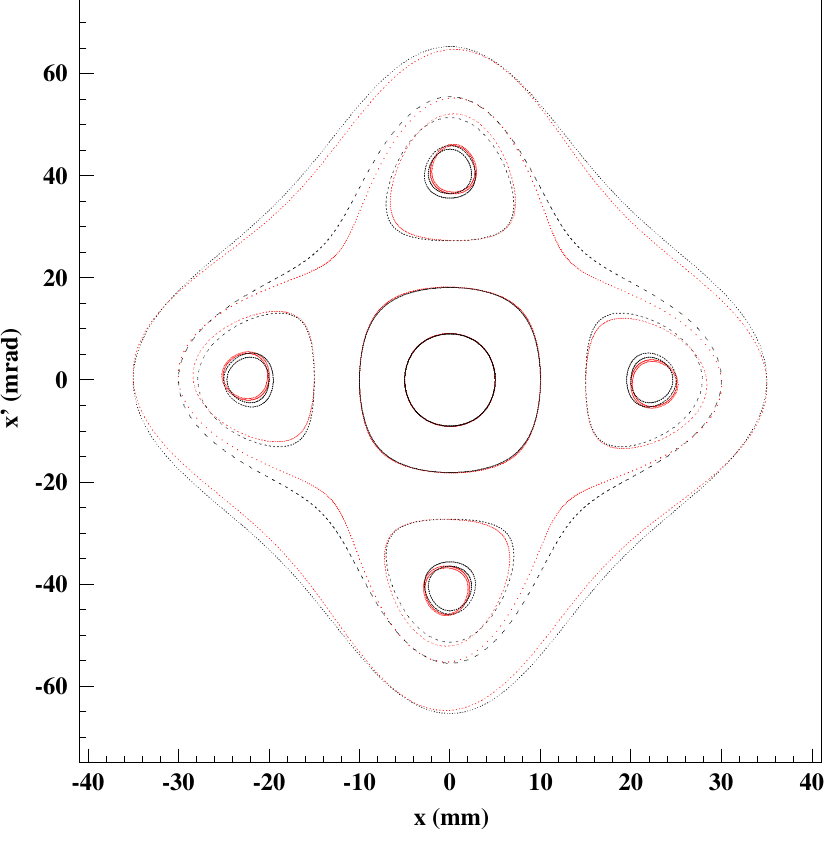
FIG. 12. Tracking results in the hori- zontal plane for 10 3 turns with the lattice as depicted in Fig. 9 (bottom). Starting coordinates are x 0 ¼ 5 , 10.0, 15.0, 20.0, 25.0, 30, and 35 mm, while x 0 0 ¼ 0 mrad in all cases. The scaling factor for the quadrupoles was chosen to be afact ¼ 1 . 218 , which corresponds to an integrated quadrupole strength of 2 . 58 = m. The rotation of the pattern is greatly reduced as compared to Fig. 11, since the quadrupole field strength is about 2 times smaller compared to Fig. 11. The results of STGFM are given in red, and results of WAVE are shown in black. As before, the focal strength was reduced by 1% in the case of WAVE to achieve good agreement of both